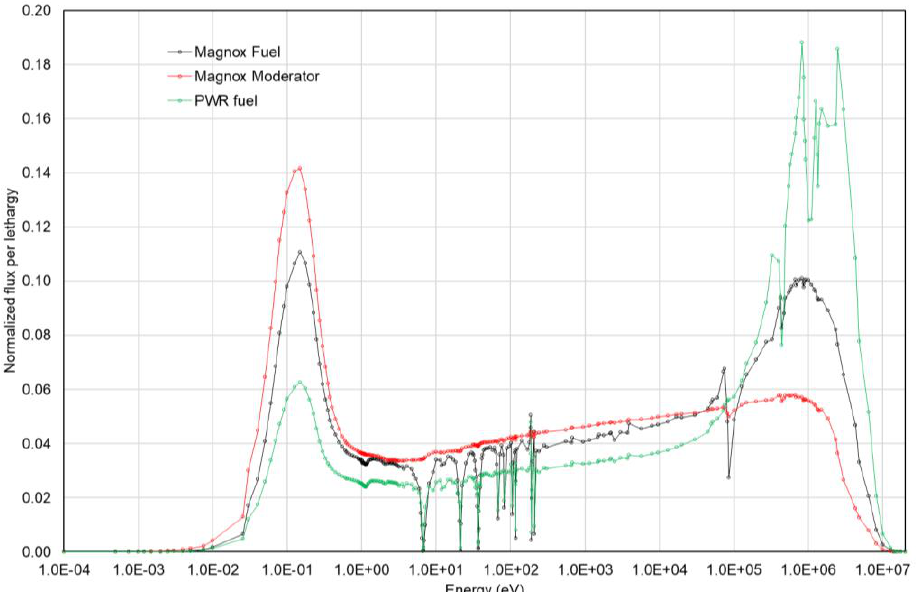
Figure 1. Comparison of neutron spractra between Magnox and